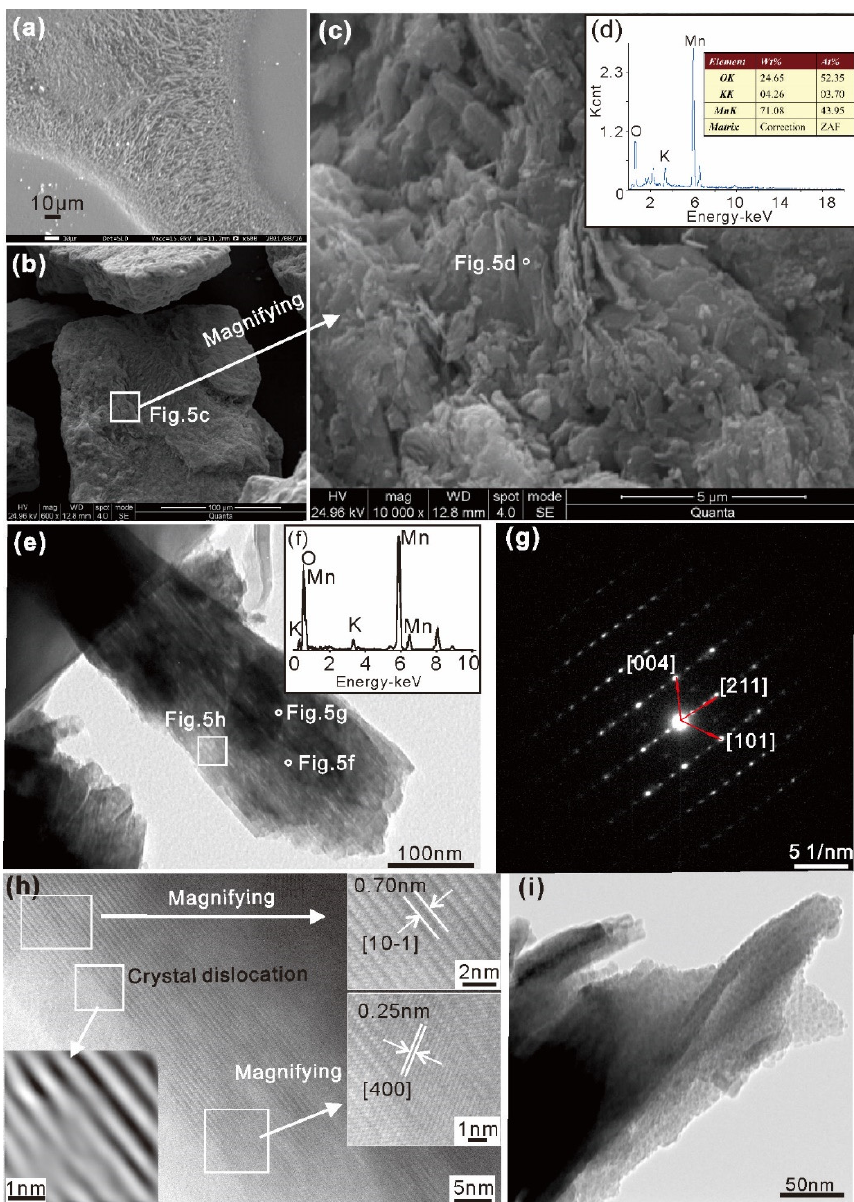
Figure 5. SEM, TEM and HRTEM images of Mn oxide ore in the Xiangtan deposit. ( a – c ): SEM images of cryptomelane crystal and its aggregate, with needle-like and fibrous structure. ( d ) The EDS results of the location shown in ( c ) correspondingly. ( e , i ): TEM images of cryptomelane aggregate. ( f ) The EDS results of the location shown in ( e ) correspondingly. ( g ) SAED patterns of natural cryptomelane in HRAEM. ( h ) Crystal lattice images of cryptomelane in HRTEM. ( i ) Pellet-shaped cryptomelane after a long irradiation by the electron beam.